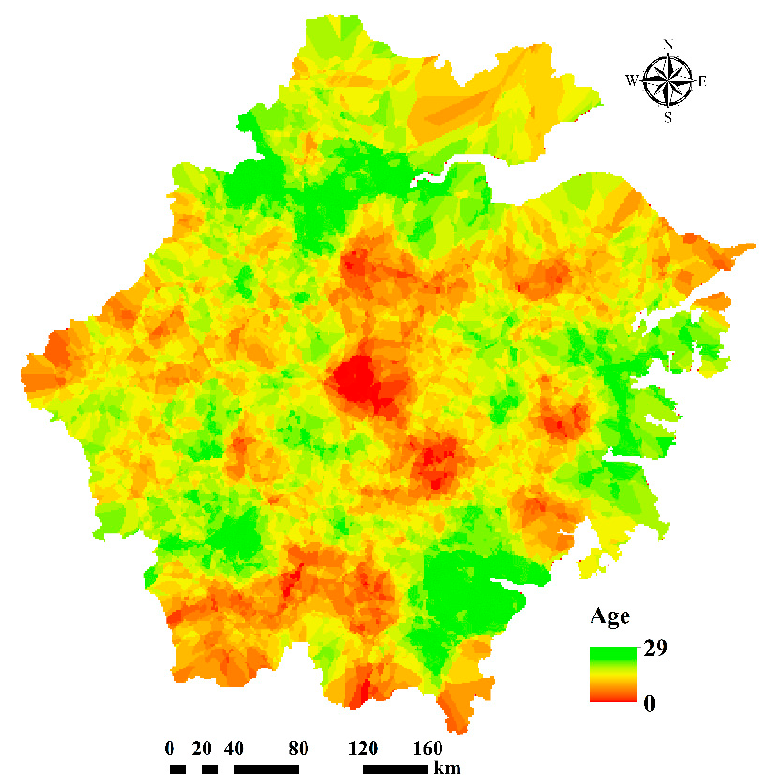
Figure 2. The age of forests in Zhejiang Province in 2004.